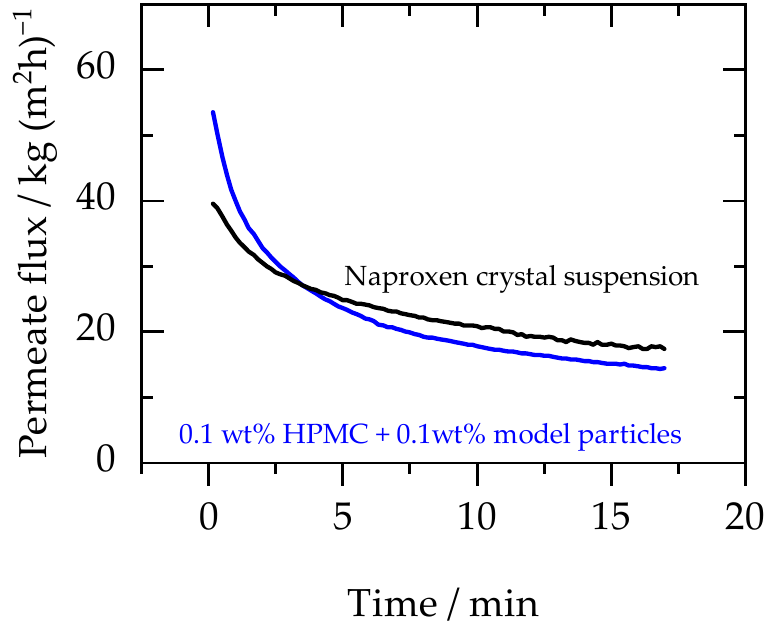
Figure 6. Permeate flux profile of naproxen crystal suspension (initial crystal load: 0.2 wt% and HPMC E3 concentration: 0.1 wt%) (black) and aqueous suspension of 0.1 wt% model particles plus 0.1 wt% HPMC E3 (blue). Experiments were performed at 30 bars and 25 °C.